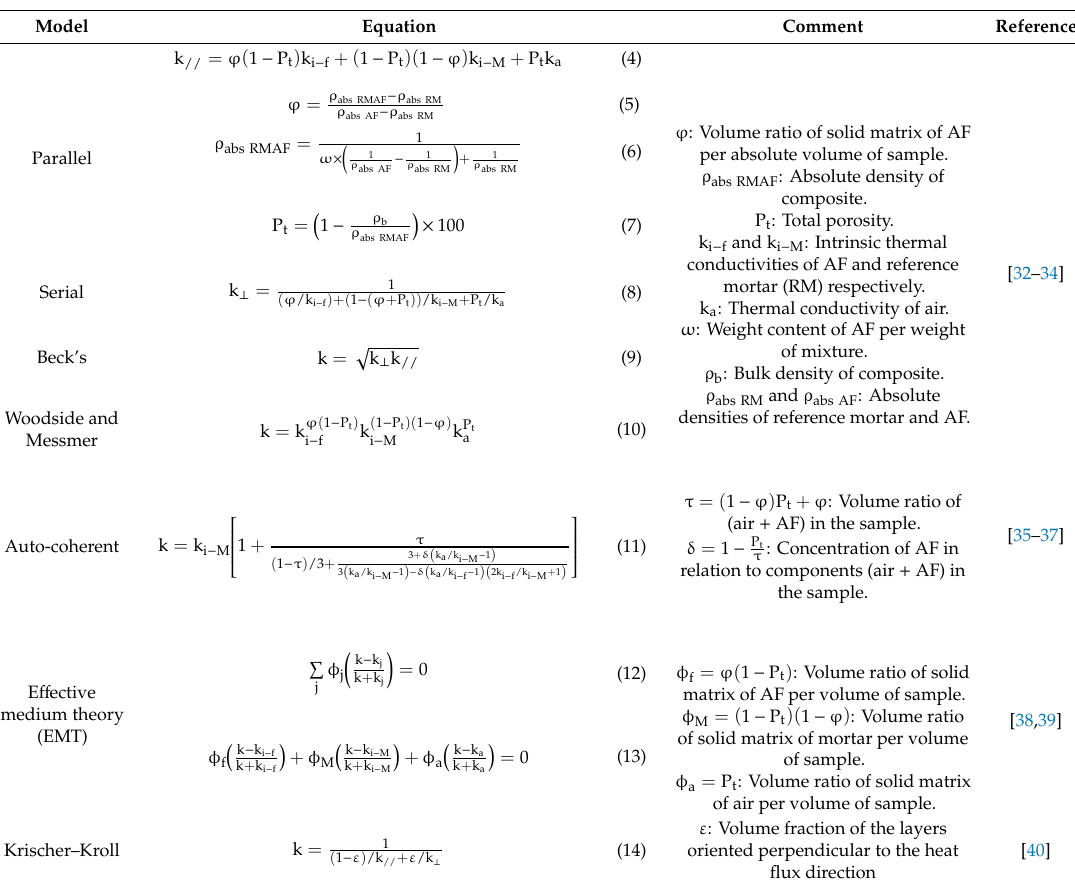
Table 2. Theoretical